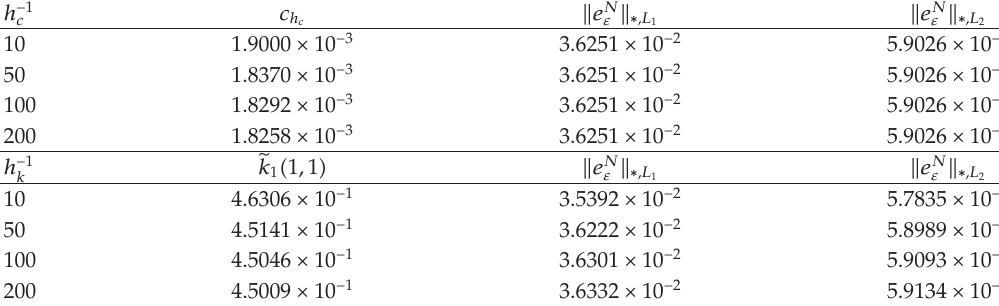
Table 6: Sensitivity of the macro-model solution to the grid used to compute c h Example